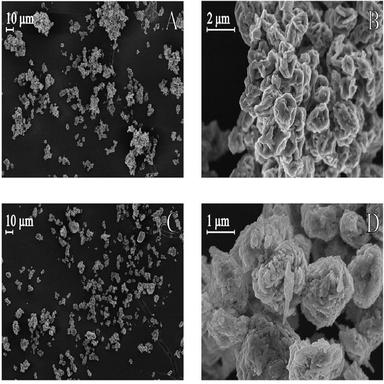
SEM microphotographs of hLF-Mt SD (a, b) and hLF-Hal SD (c, d).